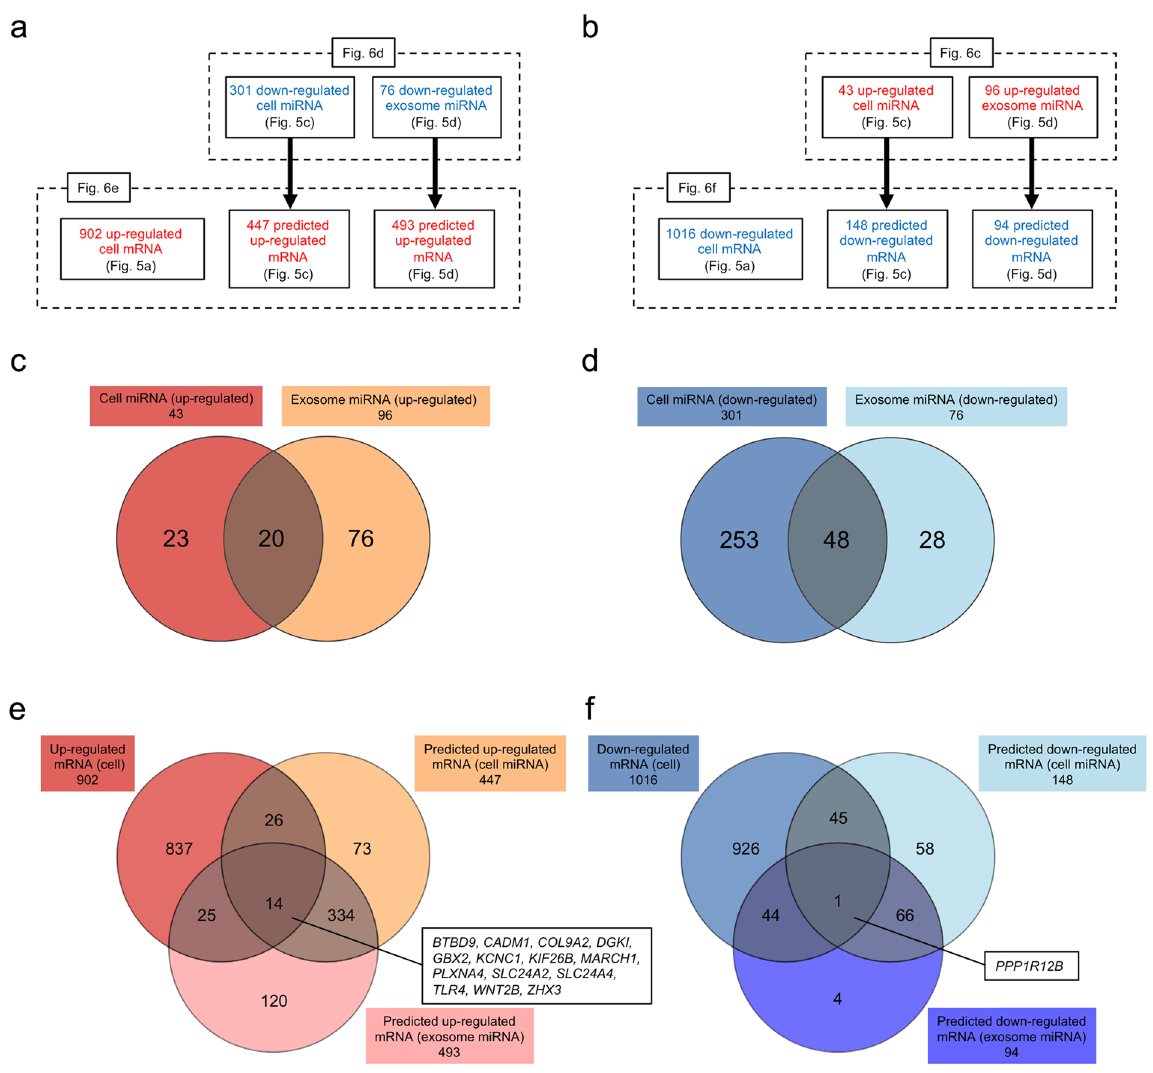
Figure 6. Integrated analysis mRNAs and predicted mRNAs targeted by miRNAs between substate 1 and substate 2. ( a , b ) Schematic diagram of integrated analysis of mRNA and miRNA microarrays. ( c ) Venn diagram of upregulated miRNAs from cells and exosomes. The miRNAs used are indicated in Fig. 5c,d and in Supplementary Tables S5 and S7. The upregulated miRNAs common to the cells and exosomes are shown in Supplementary Table S17. ( d ) Venn diagram of downregulated miRNAs from cells and exosomes. The miRNAs used are shown in Fig. 5c,d and in Supplementary Tables S6 and S8. The downregulated miRNAs common to the cells and exosomes are shown in Supplementary Table S18. ( e ) Venn diagram of upregulated mRNAs and predicted upregulated mRNAs targeted by downregulated miRNAs. The mRNAs in Supplementary Fig. S1, Supplementary Table S10, and Supplementary Table S12 were used. The upregulated mRNAs common to upregulated cell mRNAs and predicted upregulated mRNAs from miRNAs of cells and exosomes are shown in Supplementary Table S19. ( f ) Venn diagram of downregulated mRNAs and predicted downregulated mRNAs targeted by upregulated miRNAs. The mRNAs in Supplementary Fig. S1, Supplementary Table S9, and Supplementary Table S11 were used. The downregulated mRNAs common to downregulated cell mRNAs and predicted downregulated mRNAs from miRNAs of cells and exosomes are shown in Supplementary Table